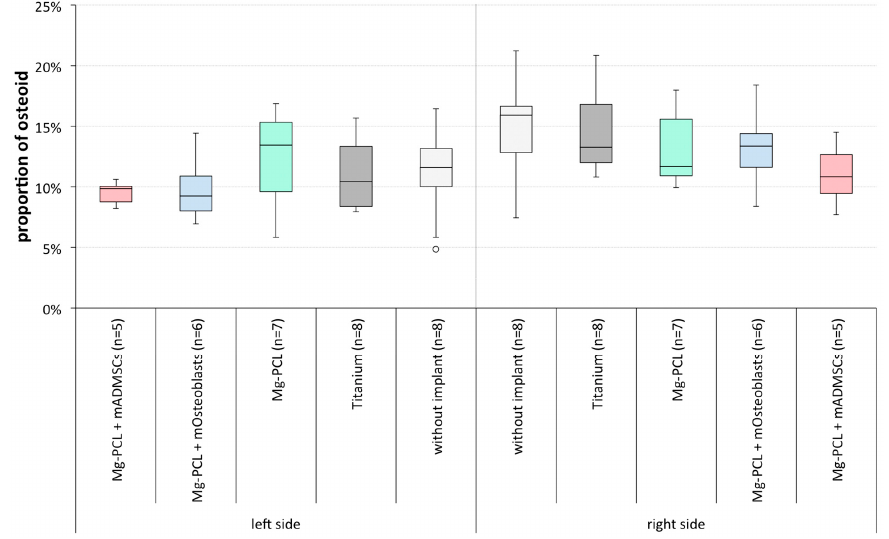
Figure 12. Proportion of osteoid on the total bone tissue (%) on slides of mice treated without an implant, with uncoated titanium implants, non-previtalised Mg-PCL implants and Mg-PCL implants previtalised with either mOsteoblasts or mADMSCs for both skull halves(whiskers = minimal and maximal values; horizontal line = median; circles = outliers).